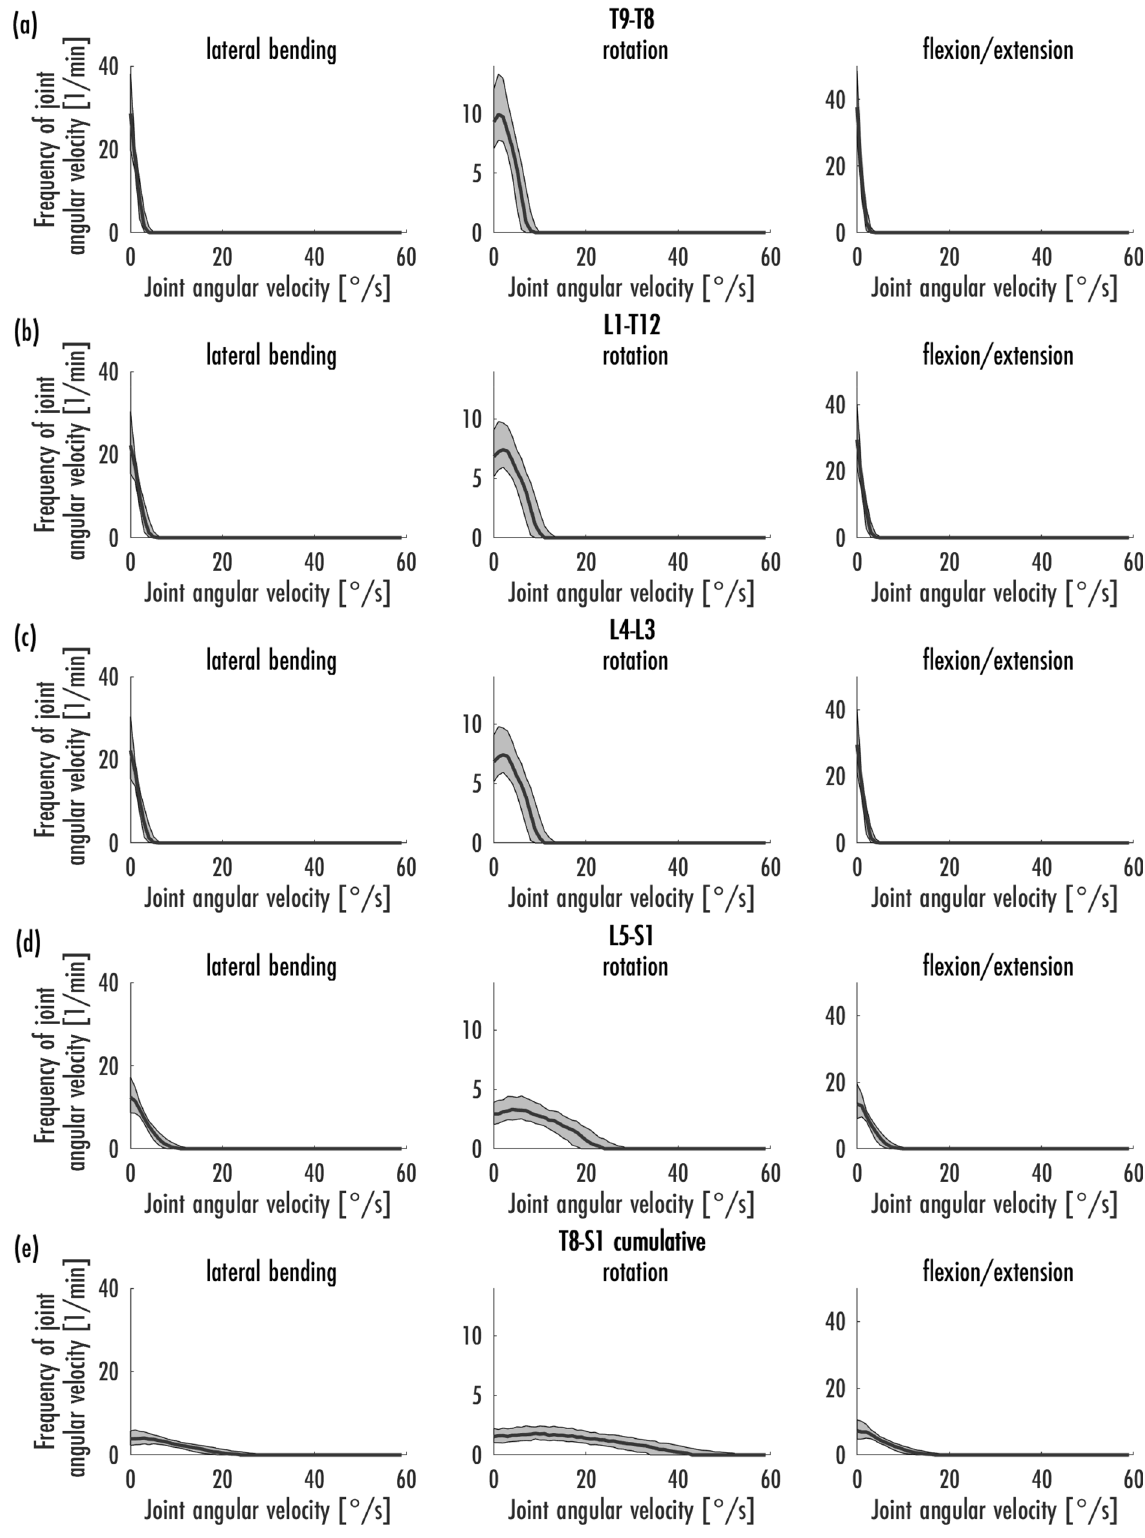
Figure 5. Frequencies of joint angular velocity [1/min] in the areas T9–T8 ( a ), L1-T12 ( b ), L4-L3 ( c ), L5-S1 ( d ) and T8-S1 cumulative ( e ) in habitual vacuuming [median, 25%- and